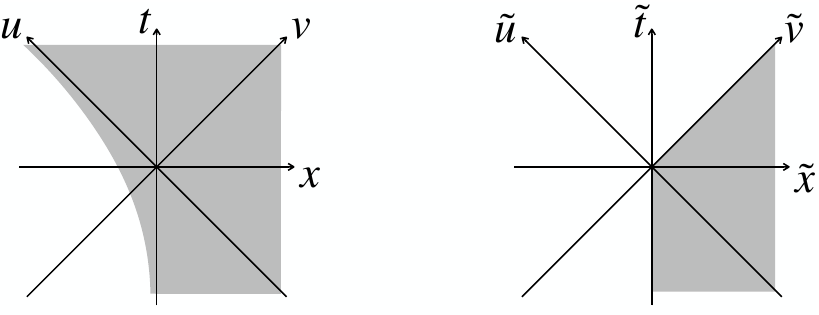
Figure 28 . Sketch of a moving mirror setup (left) and its image (right). The physical region is shaded grey. Instead of the right half plane, the physical region is given by the ˜ u < 0 portion of it. Therefore, one should impose the boundary condition at ˜ u = 0 to perform the path